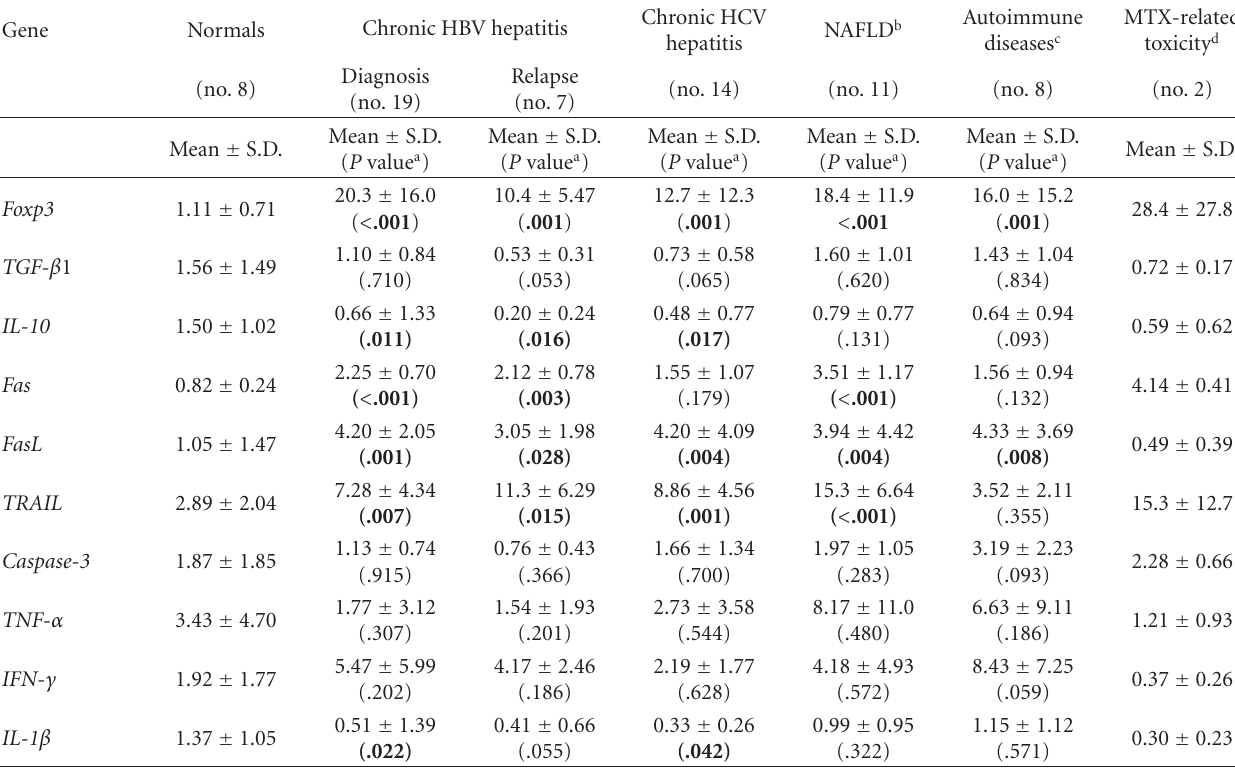
Table 2: Relative expression of the examined